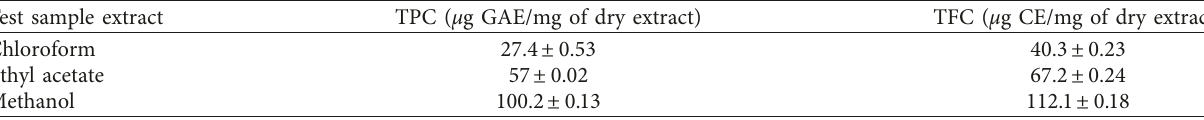
Table 4: Showing total phenol and flavonoid content of different extracts of S . gigas stem barks. Test sample extract